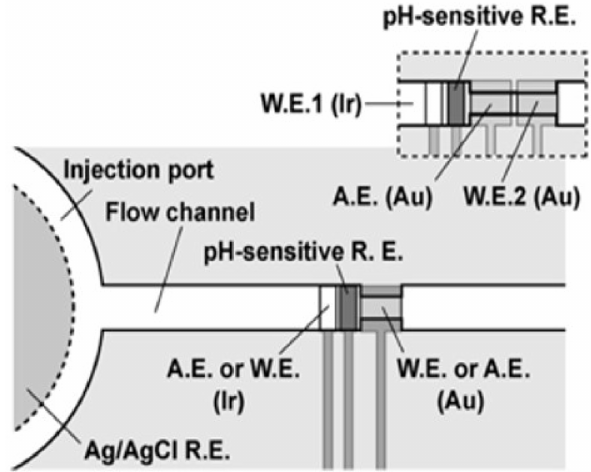
Figure 2. pH-responsive valve. For the biomolecule-responsive valve, Ag/AgCl electrode was additionally formed in the injection port (dashed line). The inset on the upper right shows the valve area of the pH filter. W.E., working electrode; R.E. reference electrode; A.E. auxiliary electrode. Reprinted permission from reference [15]. Copyright 2008 Elsevier B.V.